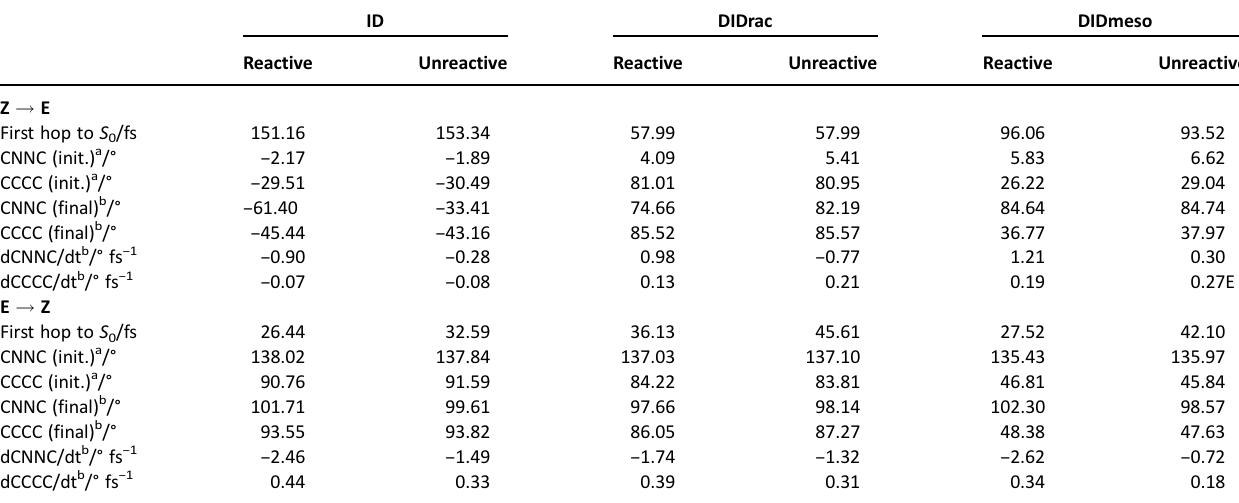
Table 7. Results for the excited-state dynamic simulation for all ID and DID